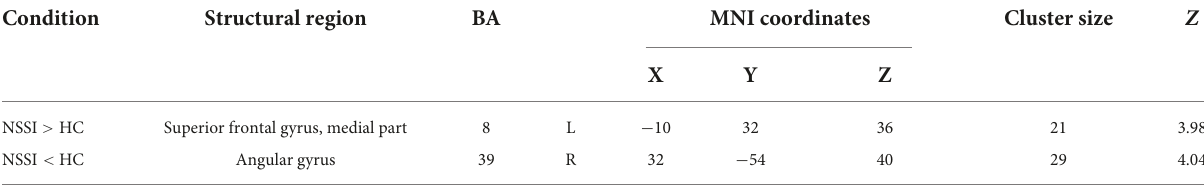
TABLE 2 Brain regions exhibiting significant activity differences between NSSI and control groups during RMET task performance. Condition